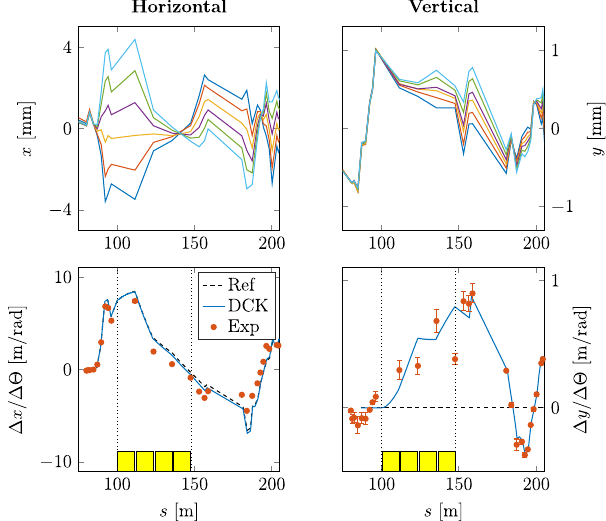
FIG. 12. Trajectory response measurement at European XFEL. The upper plots show the measured horizontal (left) and vertical (right) beam trajectories as excited by an horizontal steering magnet at s ¼ 86 m for various magnet strengths. The lower plots show the corresponding trajectory response as measured (red dots), and calculated both by the default optic server (black) and with the linear model including discrete coupler kicks [DCK, blue, cf. Eq. (22)]. The yellow rectangles in the lower row indicate the four L1